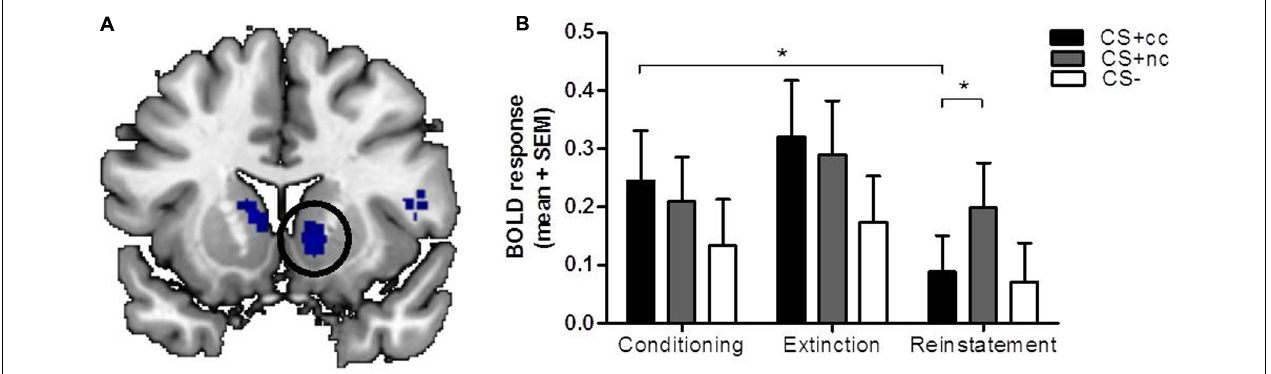
FIGURE 2 | The neural response to counterconditioned versus non-counterconditioned CS + . The figures on the left (A) show the neural responses after reinstatement to the counterconditioned versus the non-counterconditioned CS + stimuli in the ventral striatum. The bar graphs on the right (B) are a visual presentation of the response to the counterconditioned CS + (CS + cc ; black), non-counterconditioned CS + (CS + nc ; gray) and CS − (white) at the peak voxel (MNI: 12 10 − 6, z = 2.91). Compared to the conditioning phase, ventral striatal BOLD response during reinstatement is significantly decreased for the counterconditioned CS + , but not for the other stimuli. During reinstatement, the ventral striatal BOLD response for the non-counter CS is significantly higher compared to the BOLD response for the counterconditioned stimulus. The figures are displayed at p < 0.001 uncorrected for visualization purpose. ∗ = whole brain significant stimulus type (CS + cc versus CS + nc ) by phase (conditioning versus reinstatement) interaction effect.